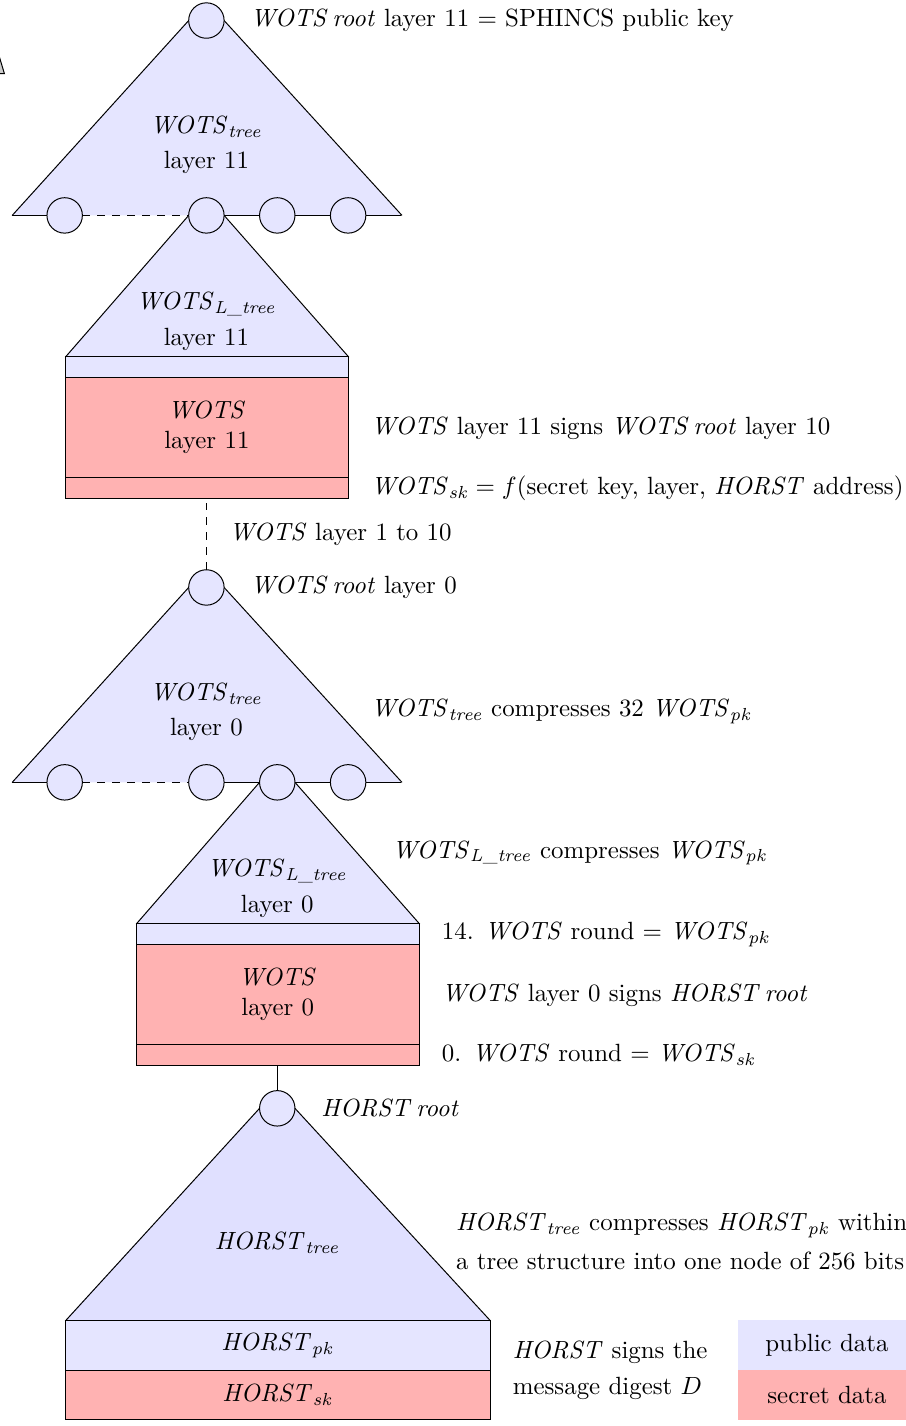
Figure 2: Tree structures are the main concept in the SPHINCS-256 scheme. Twelve WOTS signatures and several trees compress 2 60 different HORST public keys into the top root